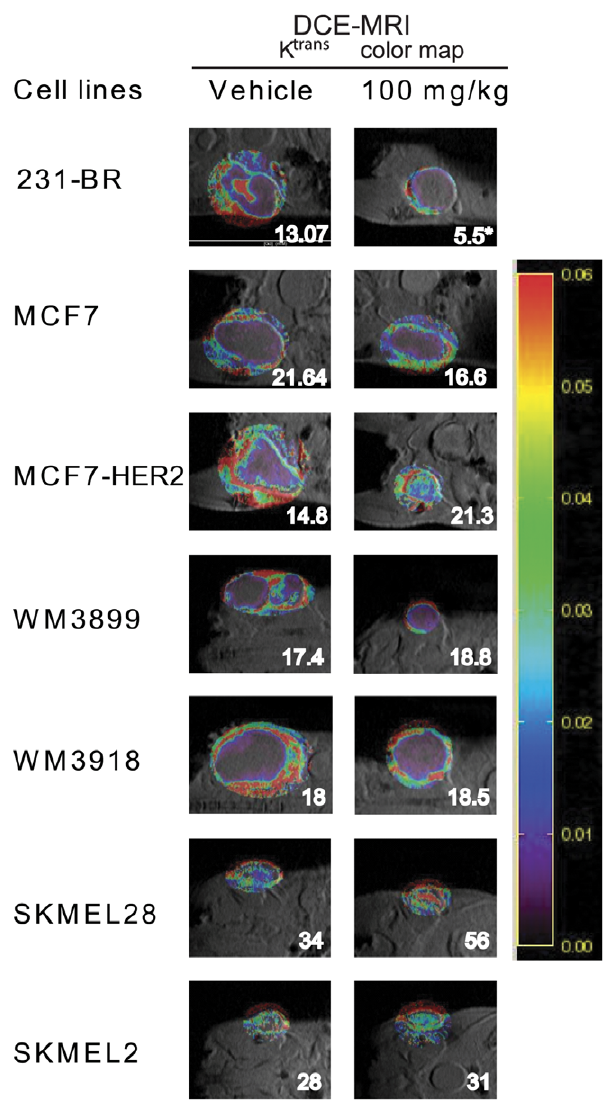
Figure 5. Effect of pazopanib on blood vessel permeability of breast and melanoma cell xenografts. Dynamic Contrast- En- hanced Magnetic Resonance Imaging (DCE-MRI) was performed on 5 mice per group at the end point. Representative photographs and K trans calculations are presented.